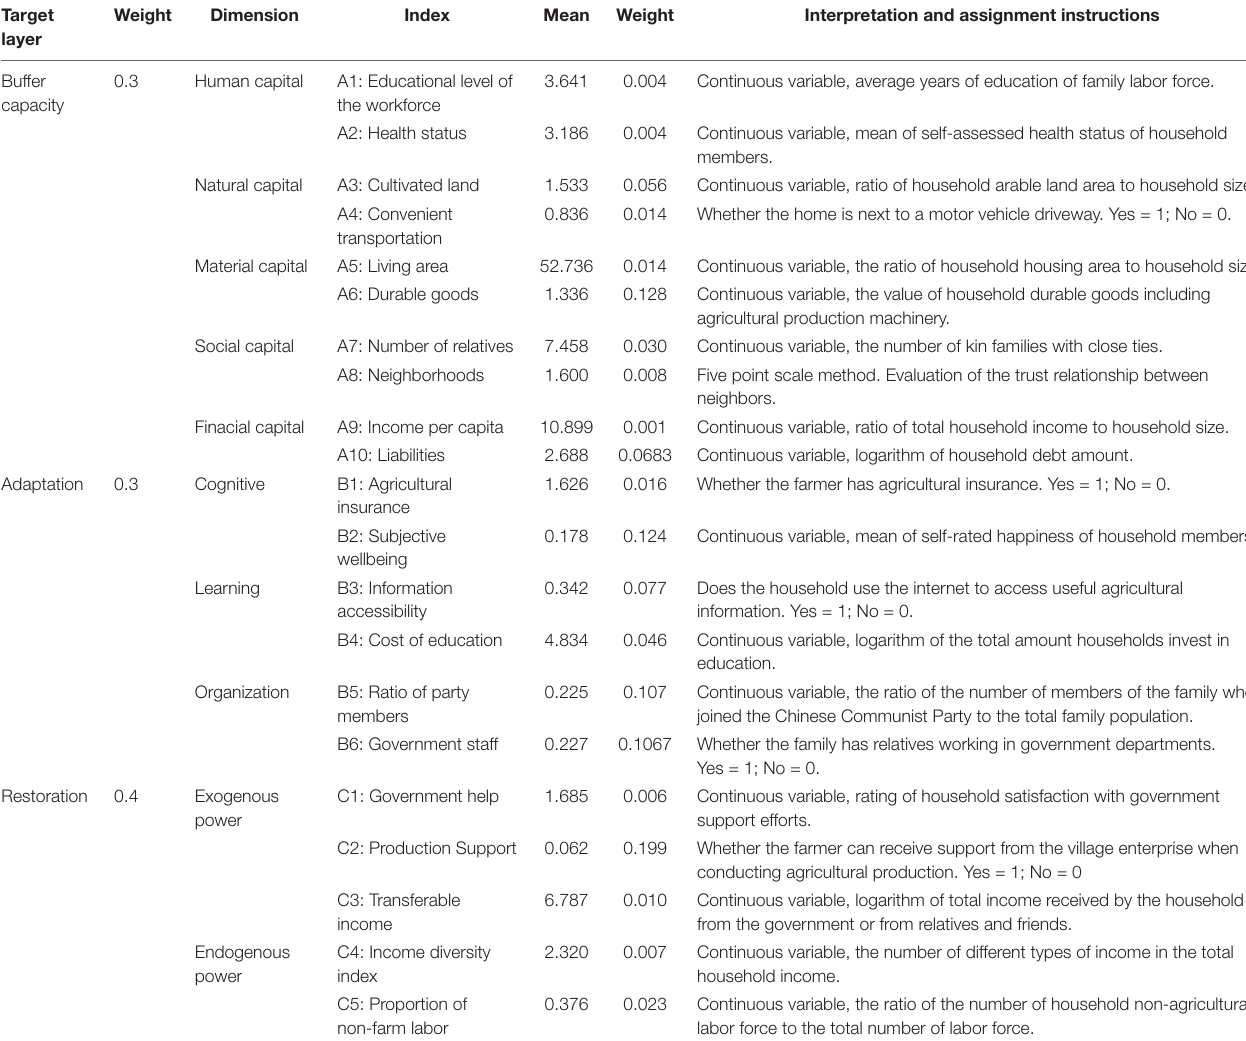
TABLE 1 | Livelihood resilience evaluation indicator system.